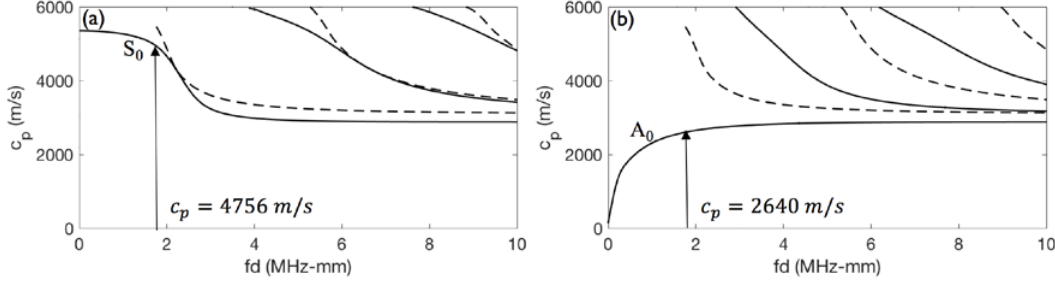
Figure 3. Dispersion curve corresponding to steel plate for ( a ) symmetric modes and ( b ) antisymmetric modes.